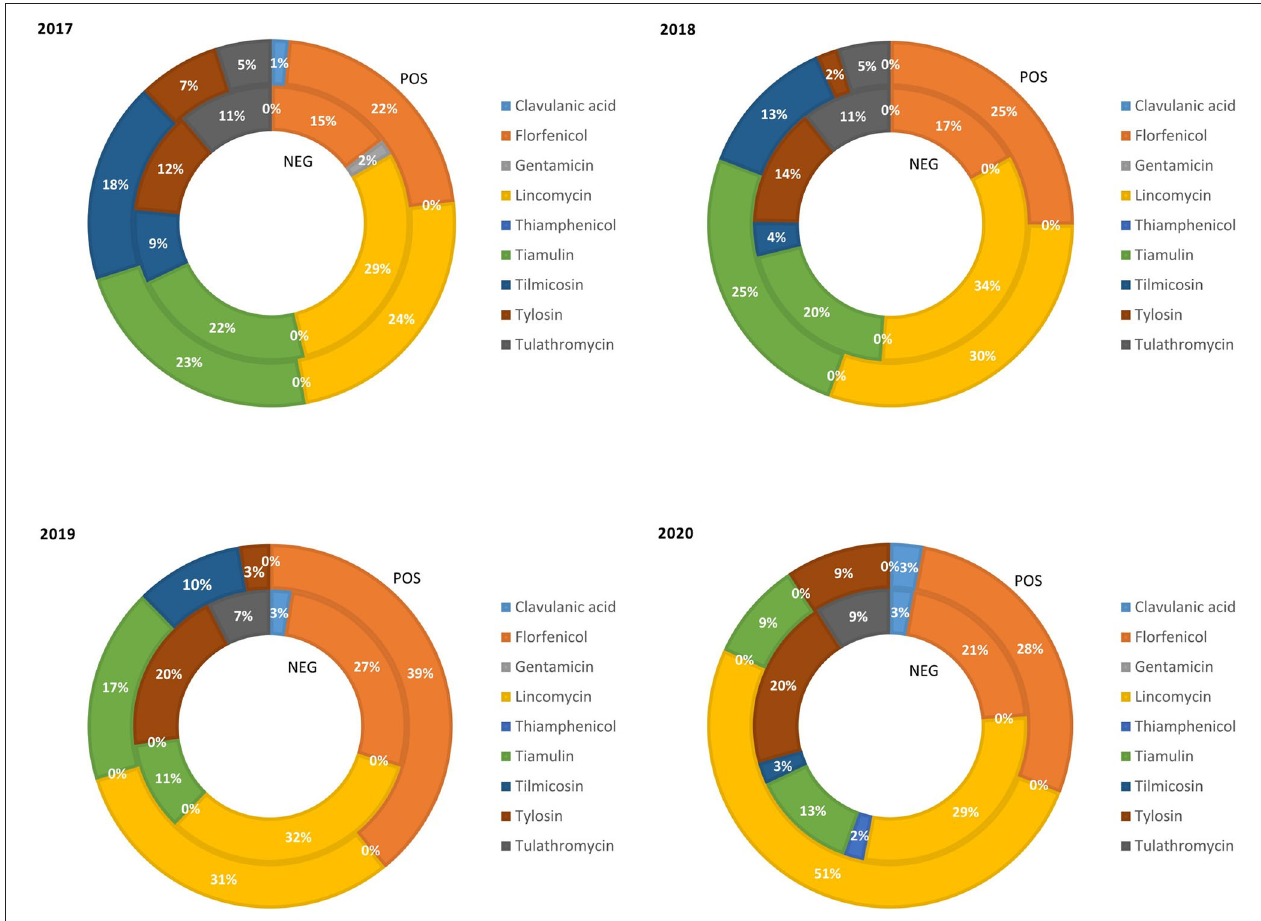
FIGURE 3 | Relative quantity of fattening pig weight treated with class C antibiotics in the PRRS negative (NEG) and PRRS positive (POS) production chains from 2017 to 2020.